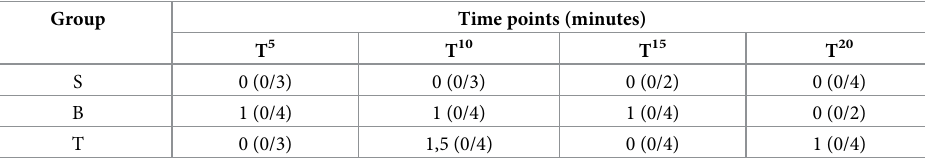
Evaluation of analgesia was performed with a cumulative pain scale (CPS) assigning a score on percentage variations of heart rate (HR), and respiratory rate ( f R ), compared with basal values; the total score is obtained from the sum of the percentage variations of HR and f R , total score greater than 10 was indicative of severe pain; the results obtained evidenced that there is no significant difference between all groups in the times